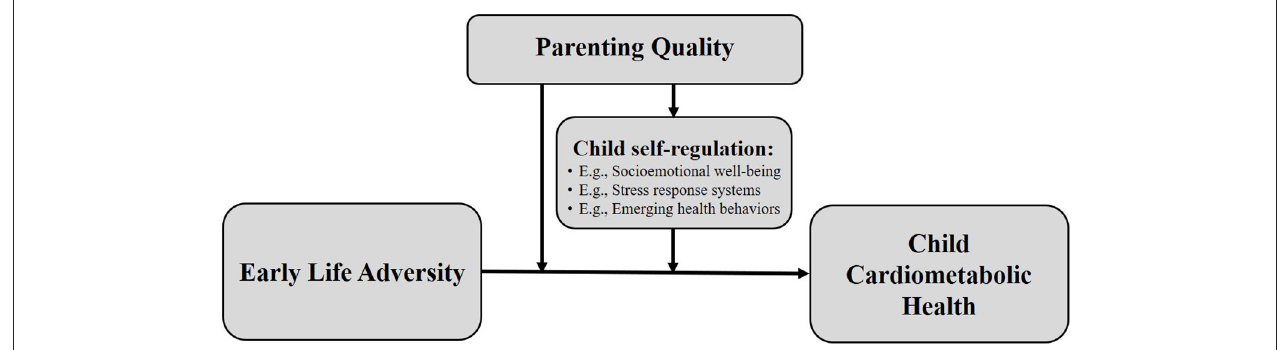
FIGURE 1 | Conceptual model depicting hypothesized role of parenting quality as a protective factor in reducing early life adversity exposures or in mitigating their impact on child cardiometabolic health, in part, through child self-regulation